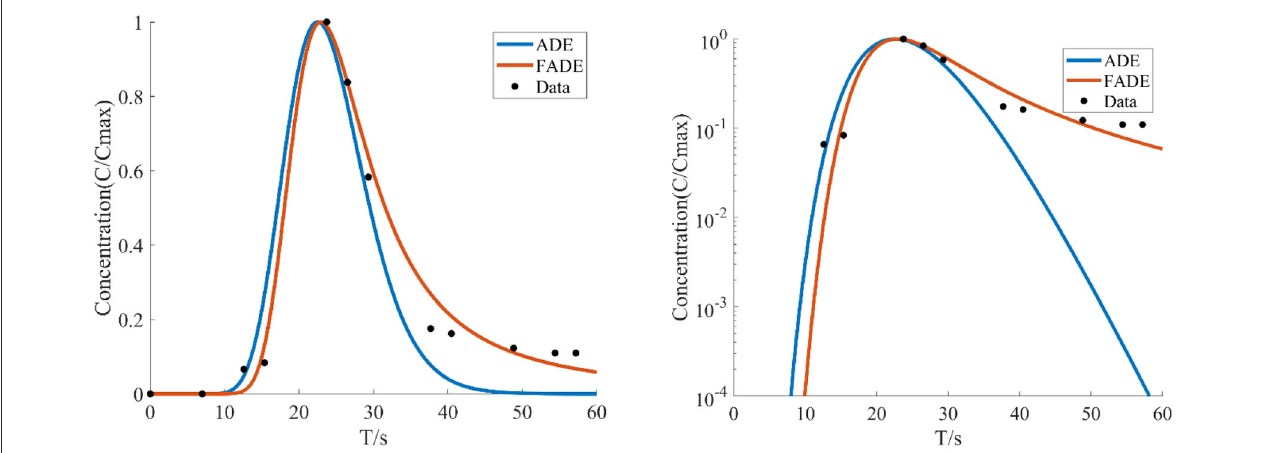
FIGURE 12 | With the average flow velocity v = 18.0257 mm/s, the average fracture width is e = 4.5mm, the concentration of the relative roughness 1 /e is 0.4444 test data, the BTCs are fitted by ADE model and FADE model.